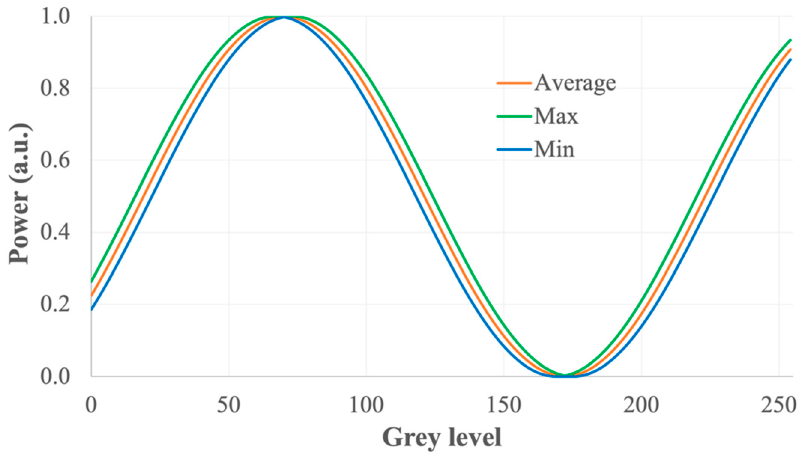
Figure 2. The simulated power response when there is no noise in the characterisation system. Subsequently, the phase flicker at each grey level was calculated based on the Equation